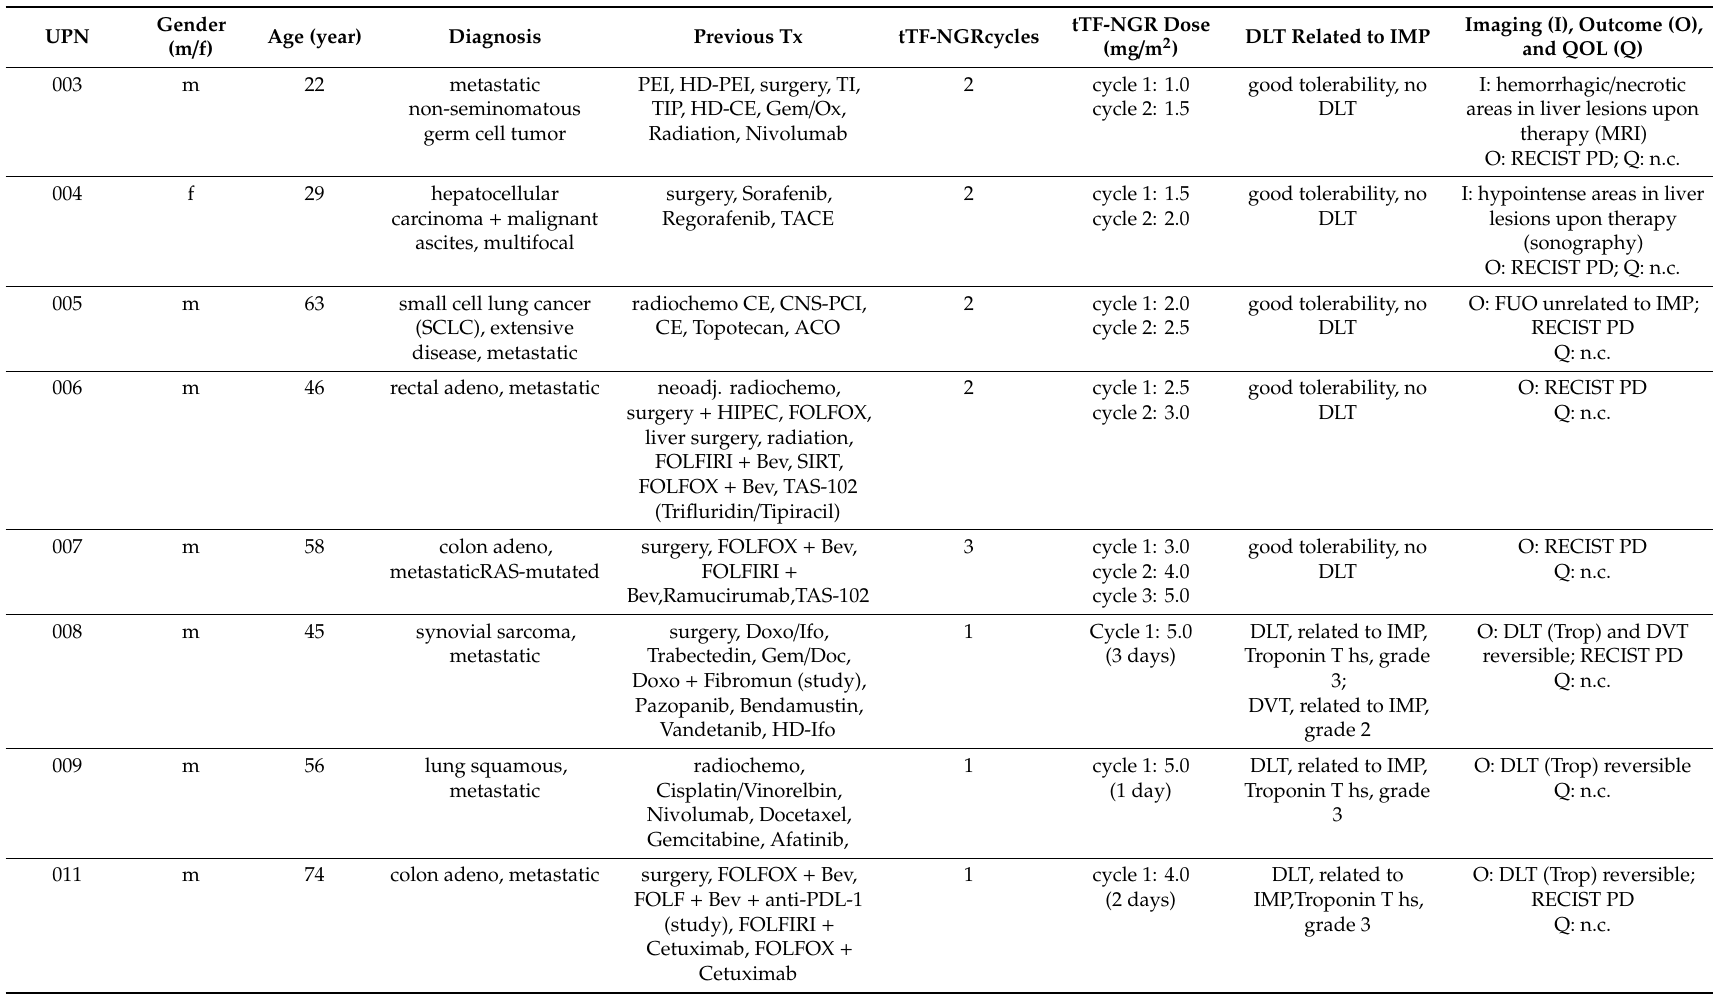
Table 1. Characteristics of the patients treated with truncated tissue factor (tTF) with a C-terminal NGR peptide (tTF-NGR). Gender UPN Age (m / f)